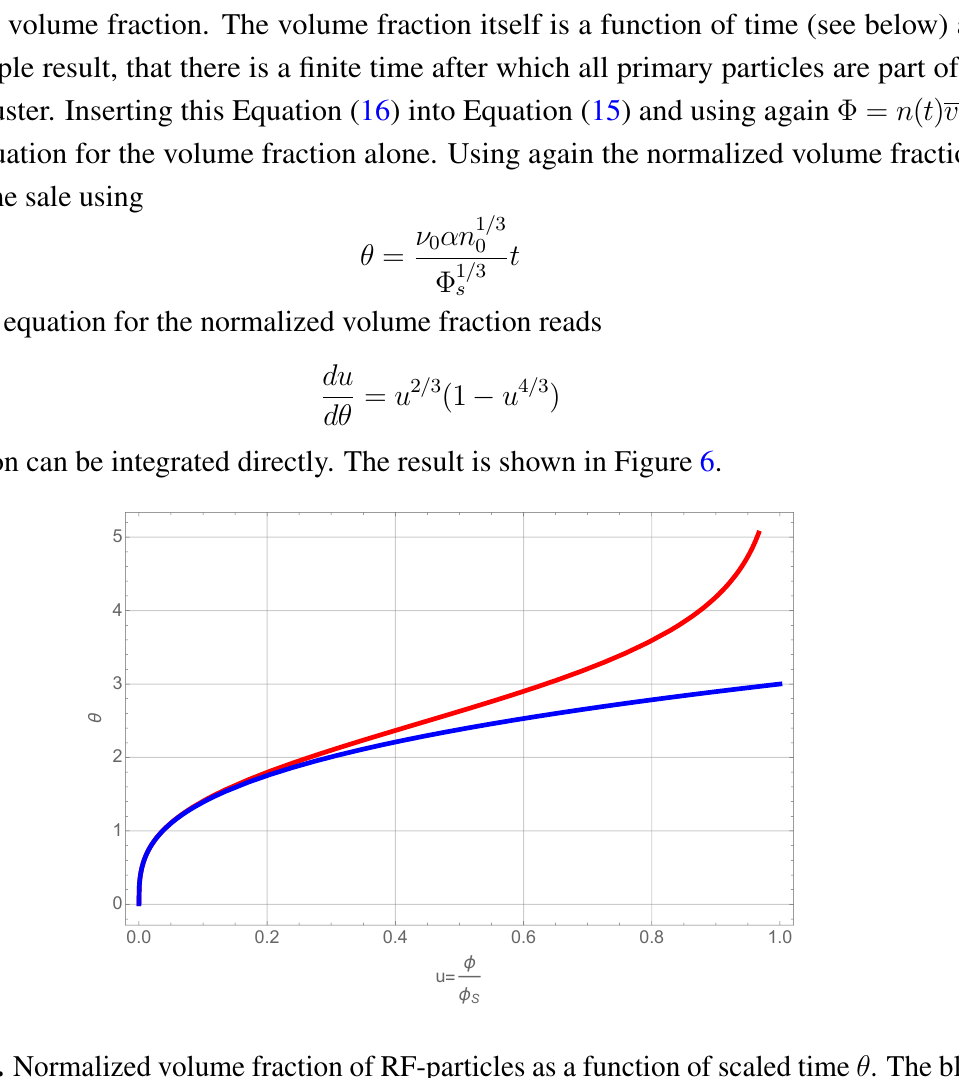
Figure 6. Normalized volume fraction of RF-particles as a function of scaled time θ . The blue curve shows the full solution and the red one the approximate one of Equation